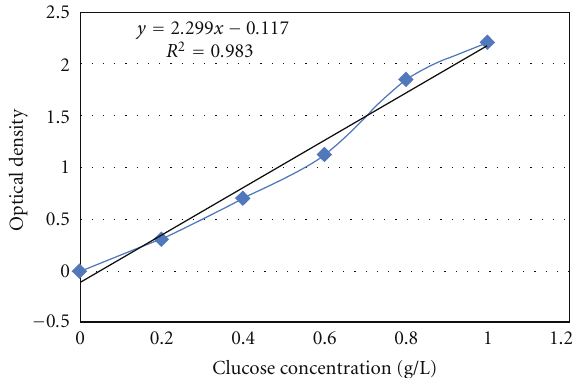
Figure 2: Standard curve of glucose concentration versus optical density at 540 nm.